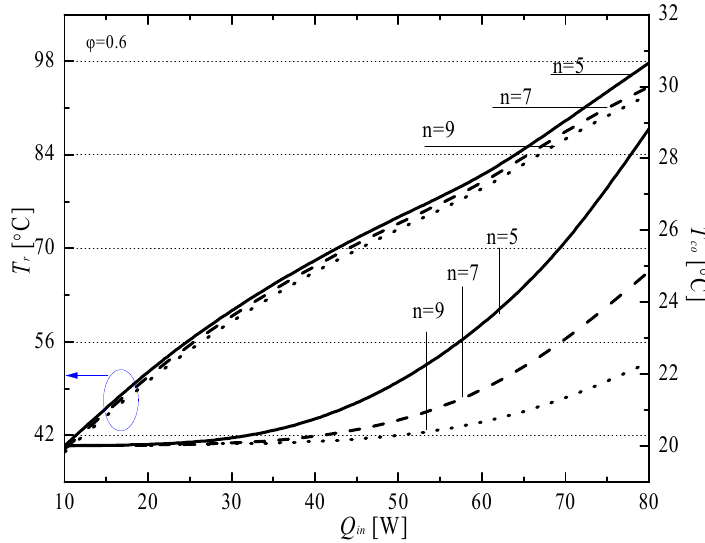
Figure 15. Variations in T r and T co as functions of thermal load and the number of condenser path turns.